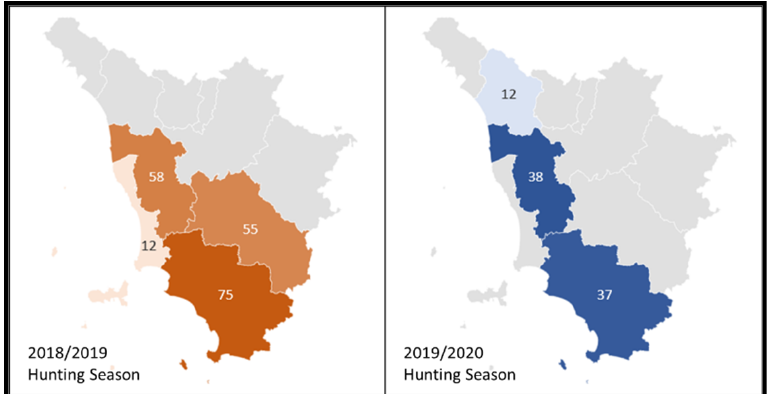
Figure 1. Geographical distribution of the sampling area included in the study (Tuscany region, Italy). The number of sampled hunted wild boar per province is indicated for hunting seasons (adapted by Cilia et al. [21]). In orange, hunting season 2018/2019; in blue, hunting season